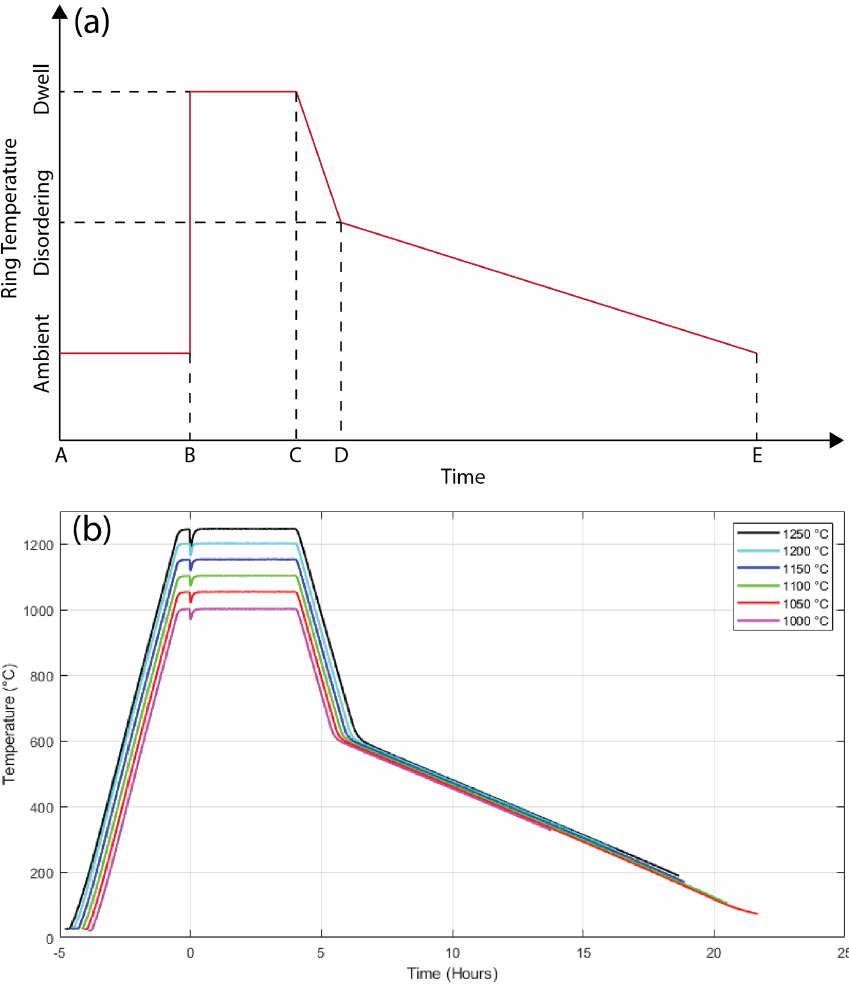
Figure 4. (a) Illustrative ideal heat treatment – adapted from Miles et al. (2019). (b) Real-world heat treatments. Time is normalized to the point when the material was hot loaded into the furnace indicated by the temperature